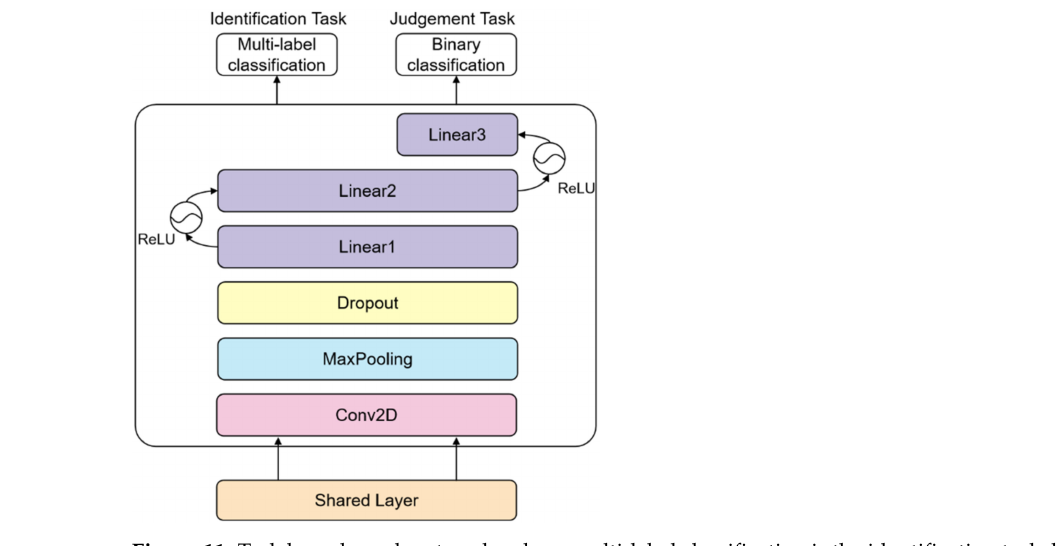
Figure 11. Task layer branch network, where multi-label classification is the identification task, binary classification is the detection task.